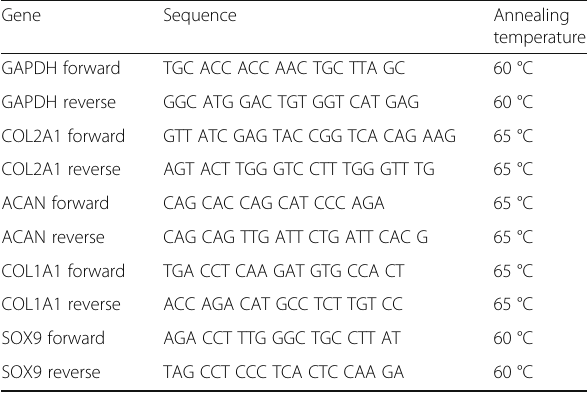
Table 2 Gene sequences of primer pairs and annealing